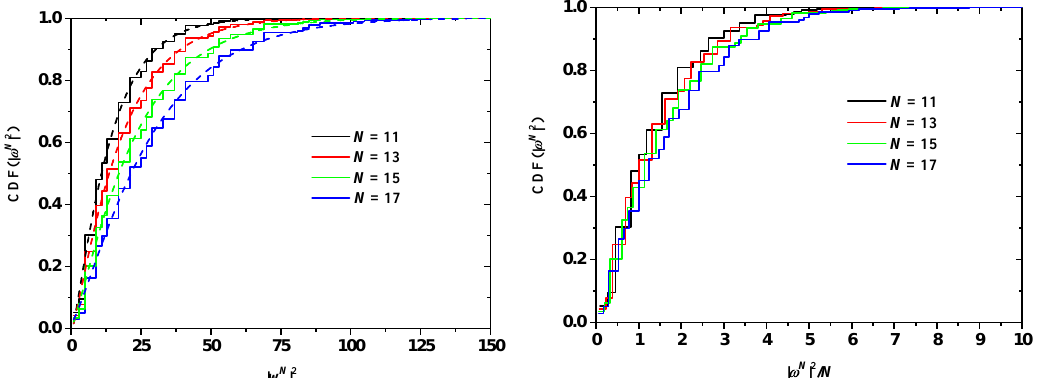
(cid:12) (cid:12) 2 for SAWs of different length in a (cid:12) ω N (cid:12)